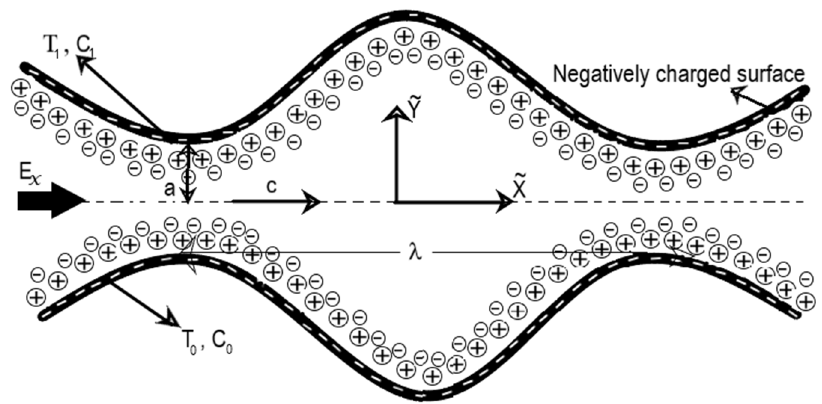
Figure 1. Schematic of the geometry of electro-osmotically modulated peristaltic flow.